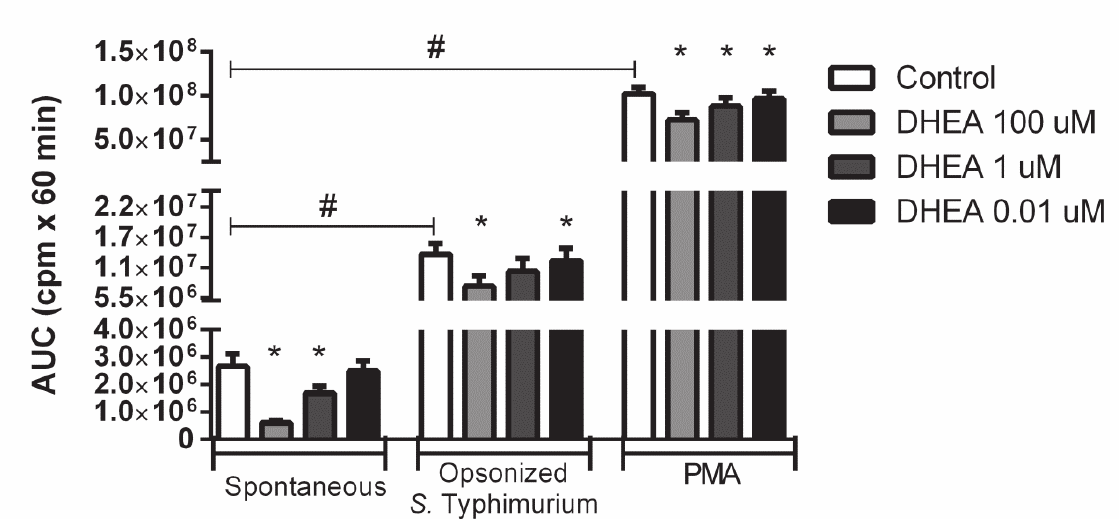
FIGURE 3 – DHEA can modulate the oxidative burst of neutrophils. Neutrophils , treated or not with DHEA, were stimulated with PMA (10-7 M) or with S. Typhimurium (MOI=10), previously opsonized with 20% normal human serum, in the presence of luminol (10-4 M). The reaction was monitored for 1 hour in luminometer and recorded in photons per minute. The graph expresses the Mean (SD) of area under the curve (AUC) of chemiluminescence of 11 independent experiments for Control and DHEA (0.01 µM) with 16 different donors, and 5 independent experiments for DHEA (100 and 1 µM) with 10 different donors. *p<0.05 vs control with the same treatment; #p<0.05 vs spontaneous neutrophil with opsonized bacteria and with